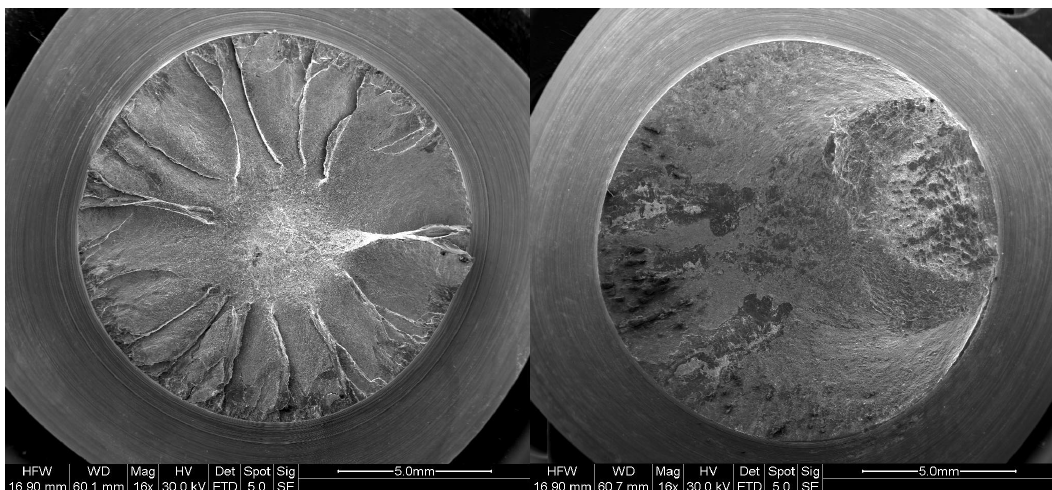
Figure 2: Fracture surfaces of (a) in phase and (b) out of phase multiaxial loading.